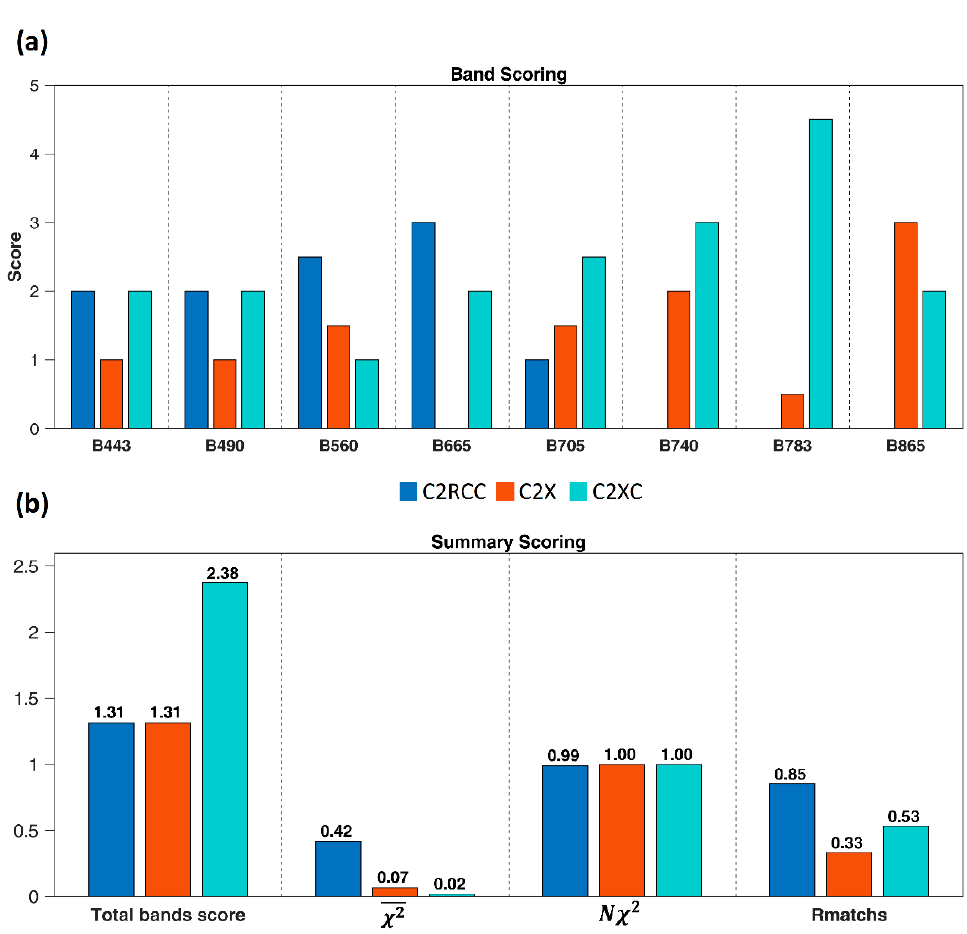
Figure 5. ( a ) Band scoring per C2-Nets Rrs. ( b ) Summary of the validation of Rrs. For representation, χ 2 is presented in absolute values, and all band scores were summed and divided by the number of available bands (N bands = 8) to compute the total band score.